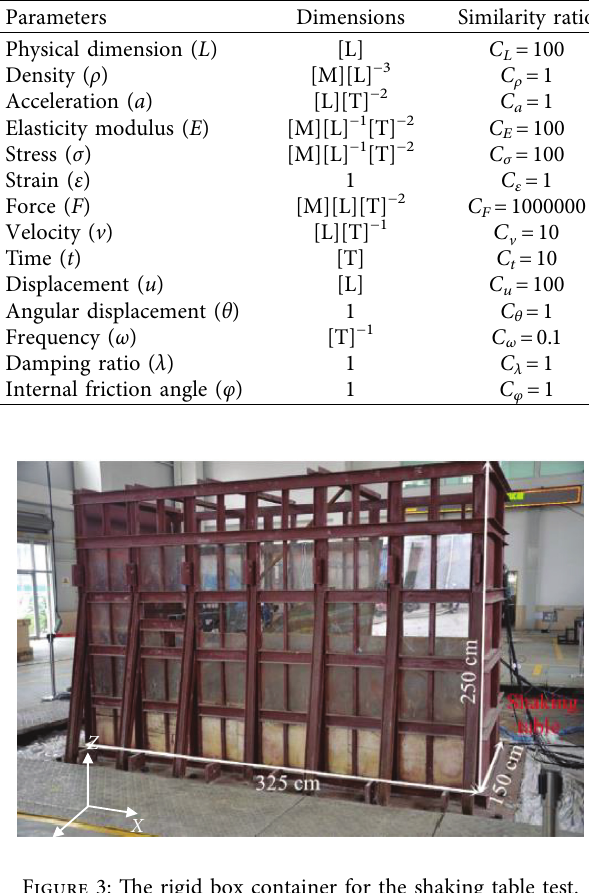
Figure 3: The rigid box container for the shaking table